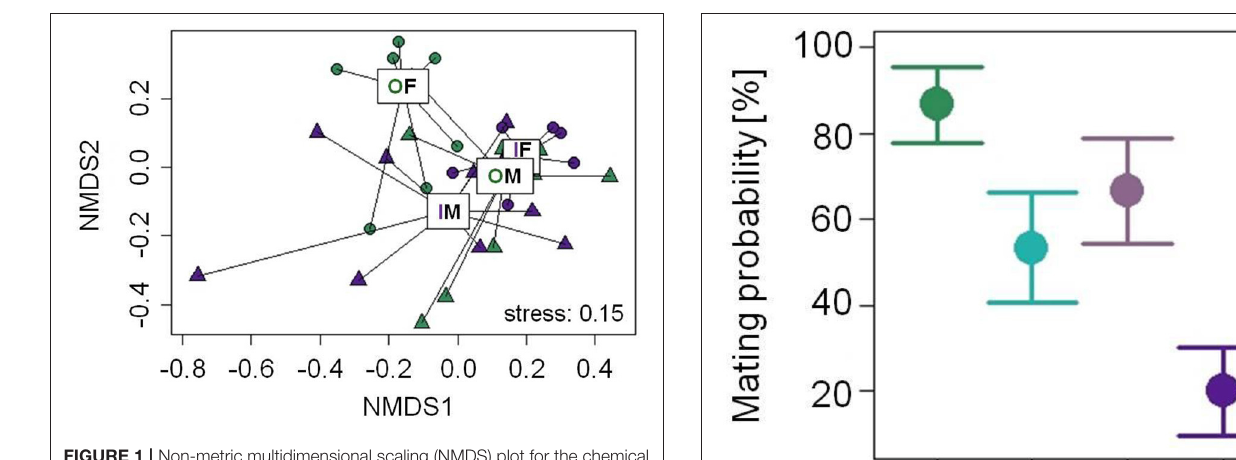
FIGURE 1 | Non-metric multidimensional scaling (NMDS) plot for the chemical phenotype, i.e., profile of putative cuticular hydrocarbons, of adult Phaedon cochleariae females (F, circles) and males (M, triangles), which either were outbred (O, green) or inbred (I, purple). Ordispiders connect individual data points with lines to displayed treatment medians (boxes). The stress-level is depicted at the bottom right of the plot. Statistical results of an ADONIS are given in Table 2 . In total, 19 compounds, which were detectable in at least 50% of the individuals per treatment and sex ( Table 1 ), were included in the NMDS plot.